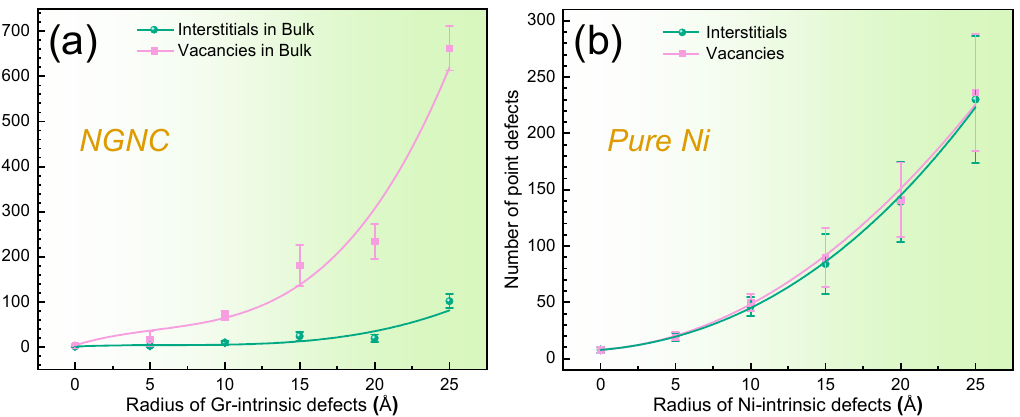
Figure 5. Number of point defects surviving in the bulk of NGNC ( a ) or pure Ni ( b ) as a function of the size of the intrinsic hole.